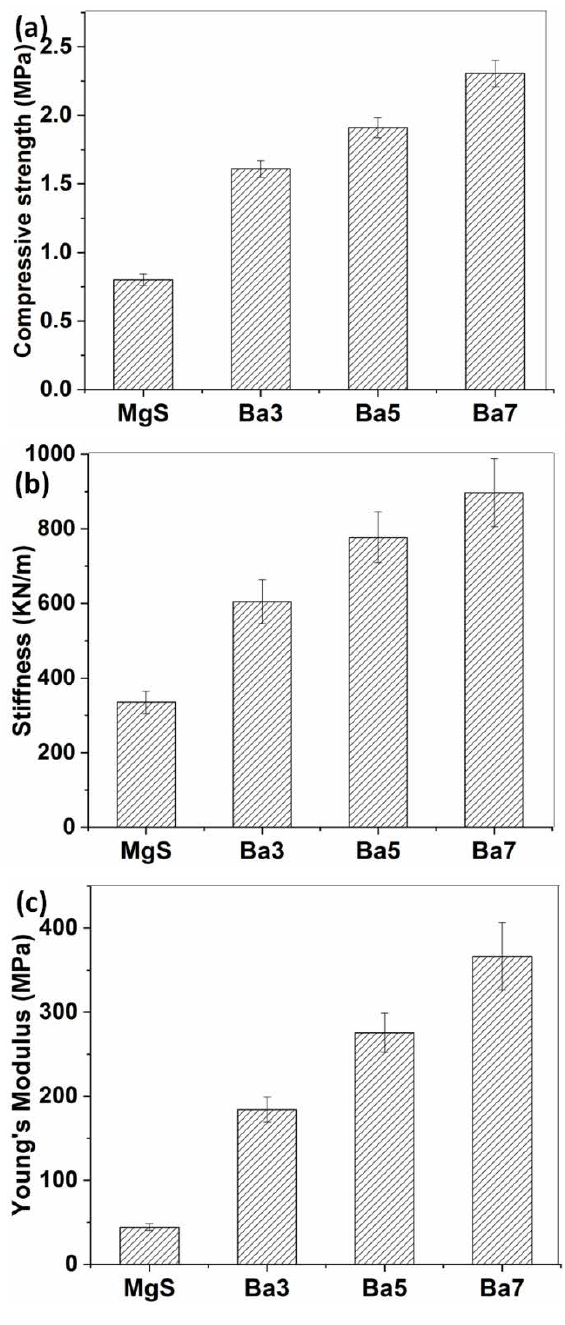
Figure 7. Mechanical properties of MgS before and after doping with BaO. ( a ) Compressive strength, ( b ) stiffness and ( c ) Young’s modulus.